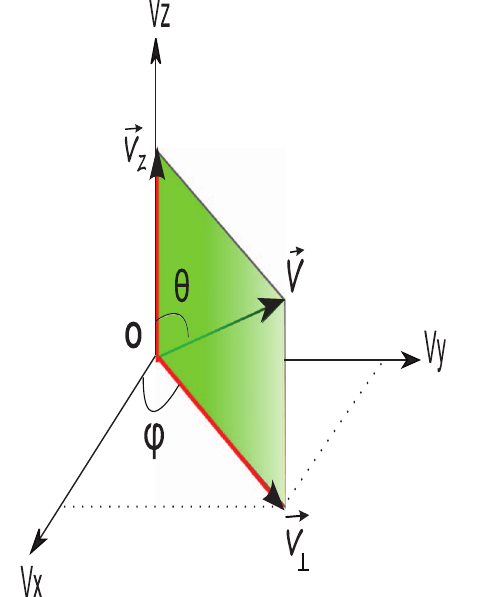
Fig. B.1. Spherical coordinate system ( v , h , / ) in the velocity space. The Vz axis is in the direction of the local magnetic fi eld B